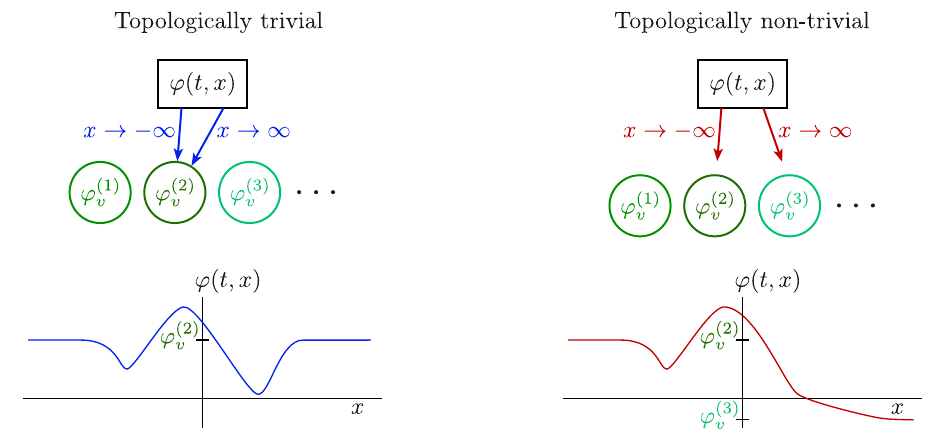
Figure 2.1: Left: Schematic representation and example of the asymptotic behavior for a topologically trivial solution. Right: Schematic representation and example of the asymptotic behavior for a topologically non-trival